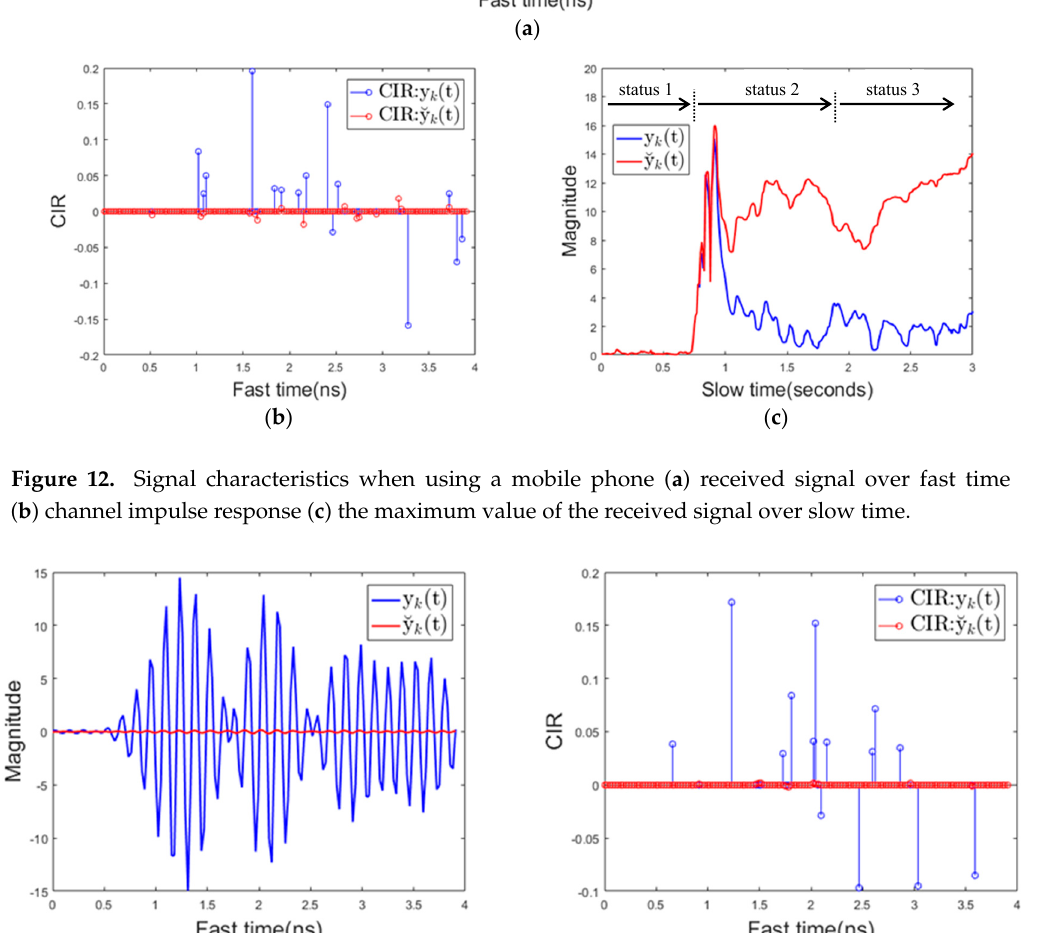
Figure 13. Signal characteristics when there is a background change ( a ) received signal over fast time ( b ) channel impulse response.